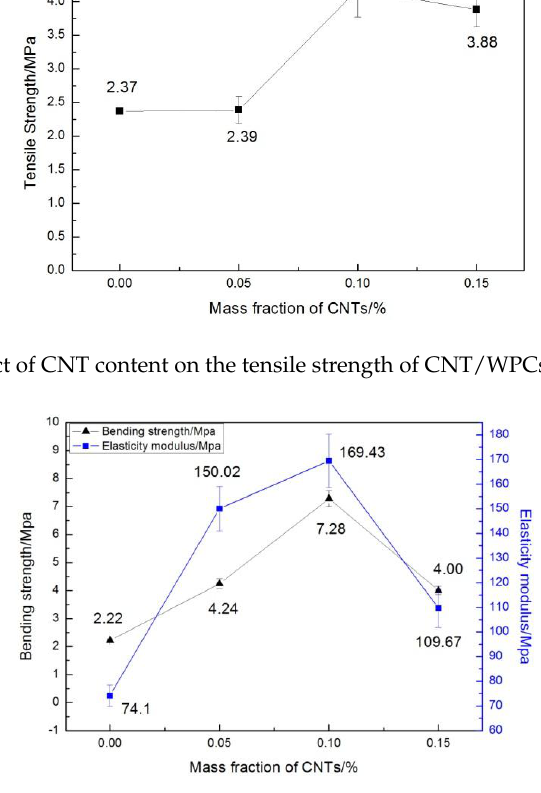
Figure 5. The effect of CNT content on the flexural strength and elasticity modulus of CNT/WPCs specimens by SLS.